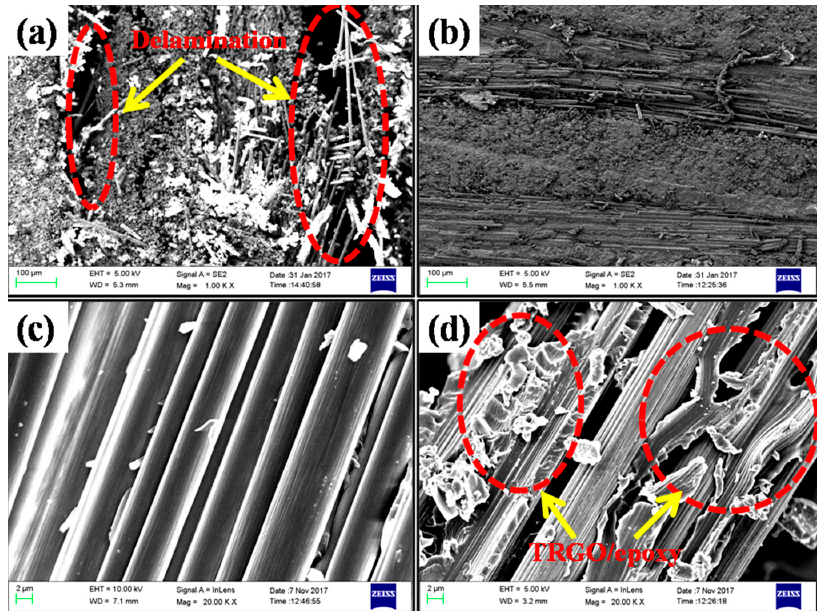
Figure 5. Fracture surfaces after ( a , b ) short beam shear test and ( c , d ) single edge notch bending test of the pure and 0.2 wt% TRGO incorporated CF/epoxy composites respectively.